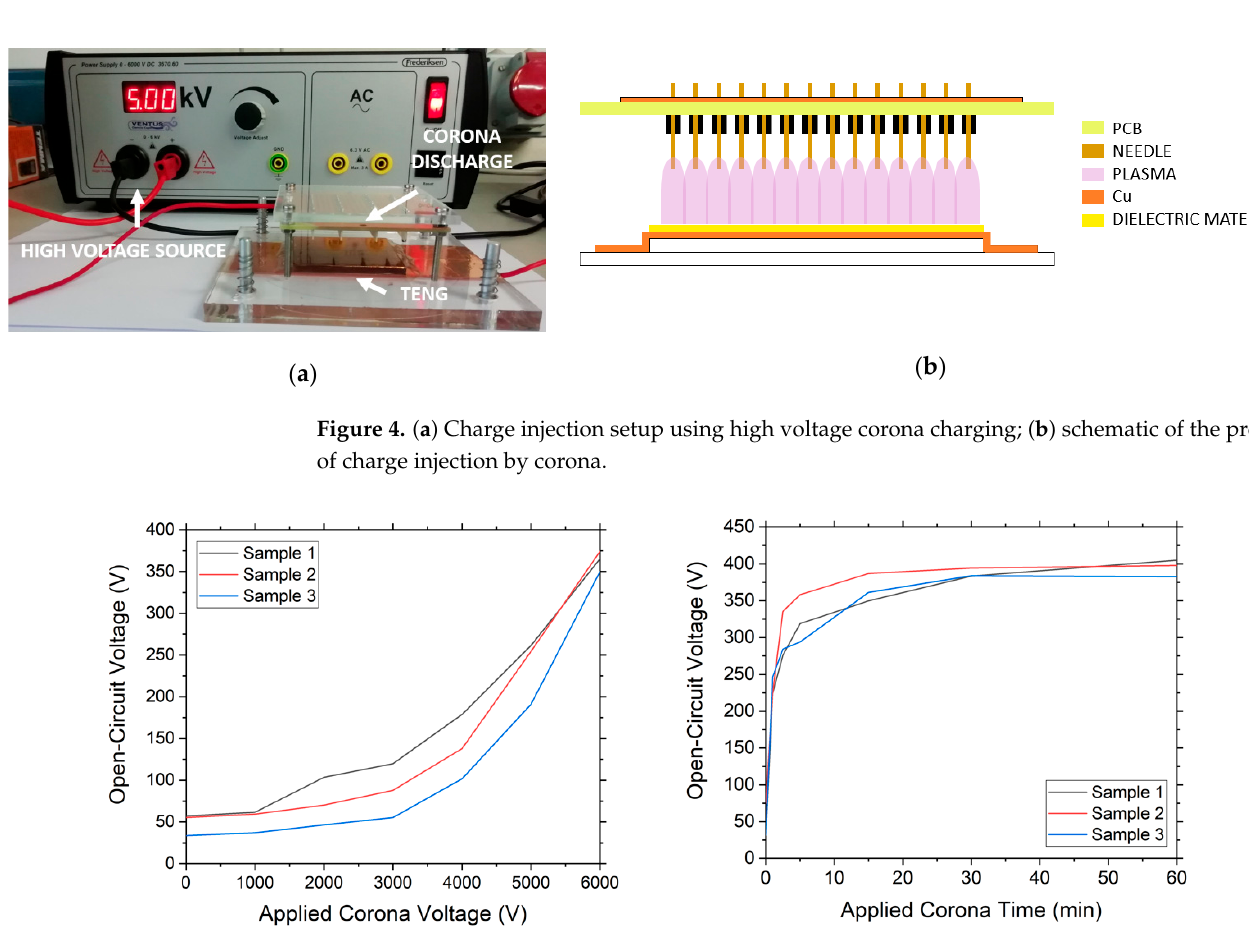
Figure 5. ( a ) Graph of the generated open-circuit voltage as a function of the voltage applied to the corona discharge; ( b ) graph of the open-circuit voltage that can be generated by the material as a function of the injection time with a constant corona discharge voltage of 6000 V.